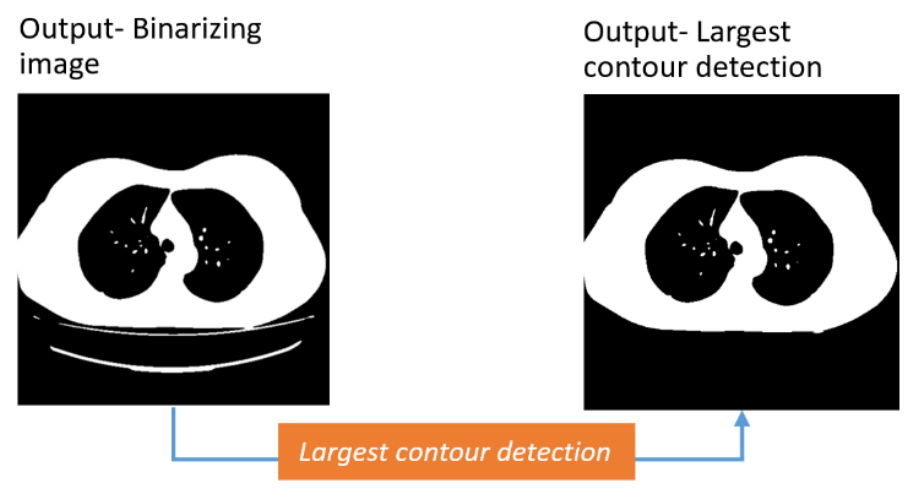
Figure 13. Curved line removal with largest contour detection.